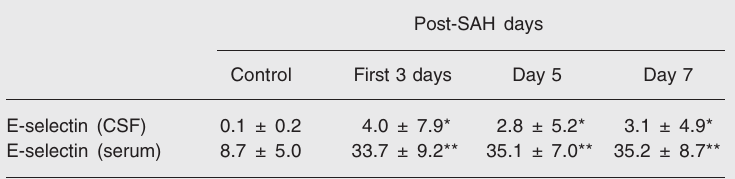
Figure 1. Comparison of soluble E-selectin concentrations in the CSF of SAH patients and con- trols with hydrocephalus and in the serum of SAH patients and controls with hydrocephalus. The squares represent the means ± SD and the bars de- note the range of values (min/ max). The differences in the con- centrations of E-selectin be- tween the two groups at the three time points were statisti- cally significant (P = 0.001